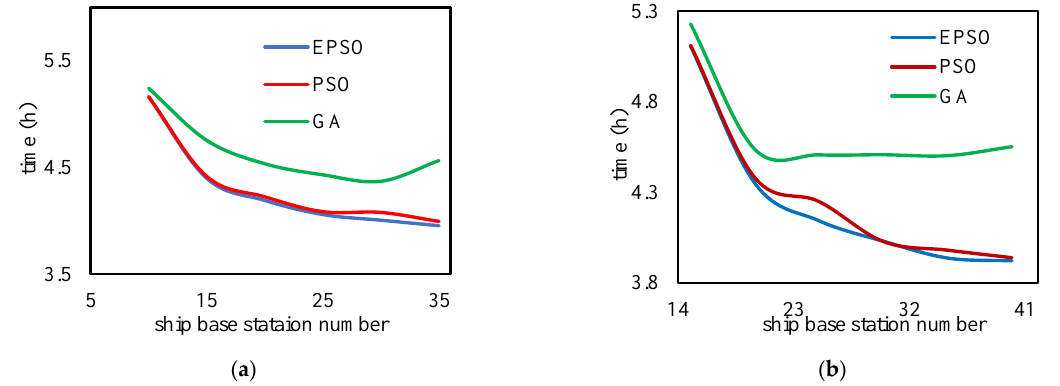
Figure 5. Rescue time cost for different models considering both ship and aircraft base stations. ( a ) Time distributions with 5 aircraft stations. ( b ) Time distributions with 10 aircraft stations.